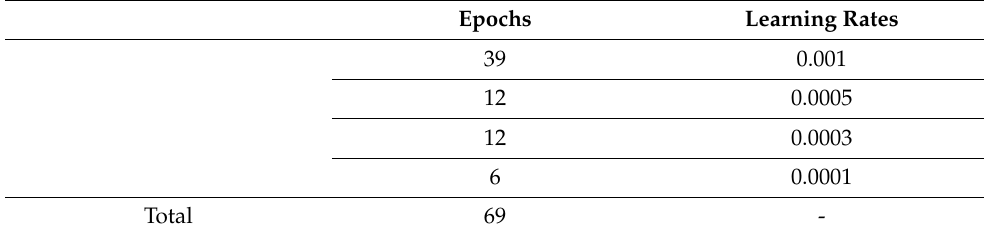
Table 1. Learning rate schedule for the state-of-the-art